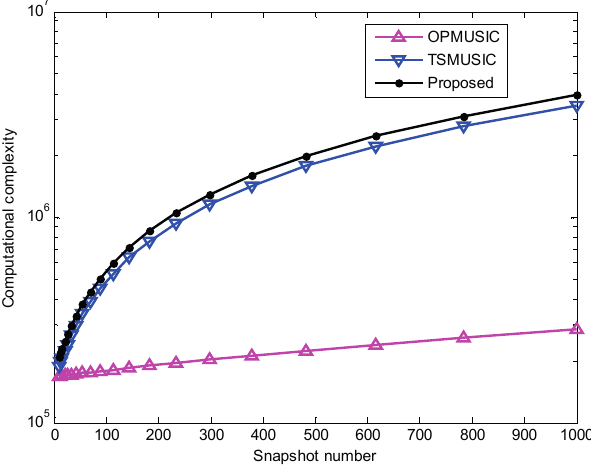
Figure 11. Computational complexity of the three methods versus snapshot